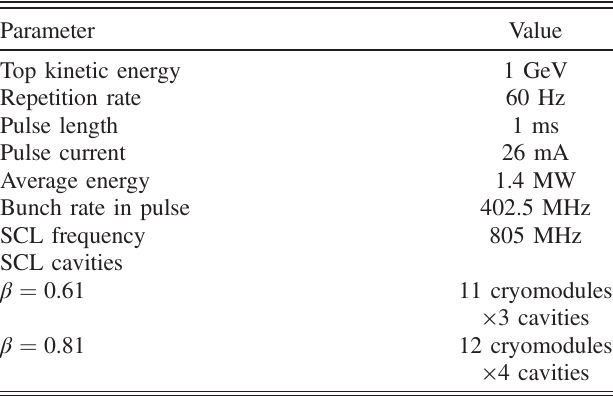
TABLE I. SNS beam and linac parameters.